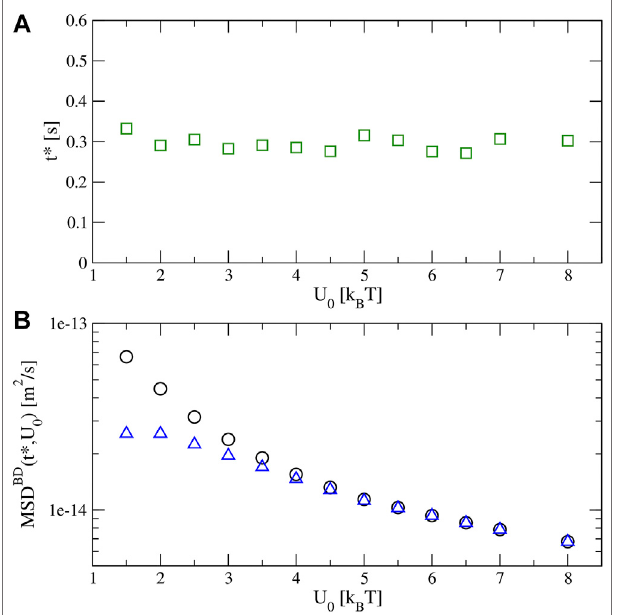
FIGURE 10 | (Color online) Random walker MSD fi tting of Brownian dynamics simulations in which the size of the periodic cell is L (cid:2) 8 microns for different energy barriers U 0 (in K B T units). The fi tting parameters used in the random walker are the spatial and time increments a # and dt #, which determine the short-times diffusion coef fi cient D 0 ; and the cage size L # and the jump probability p , which determine the long-times diffusion coef fi cient D M . These values are explicitly indicated in the